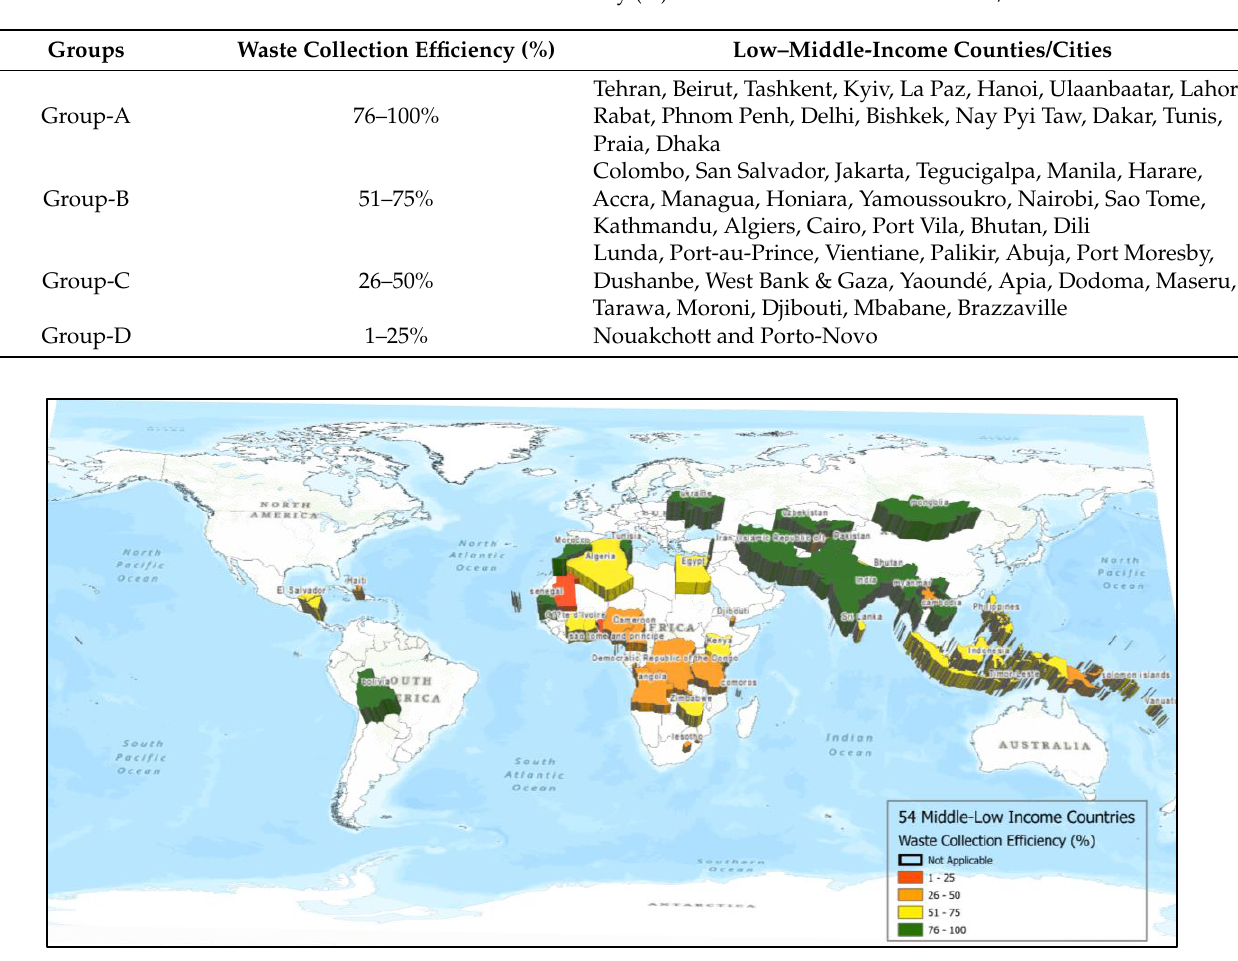
Table 1. Waste collection efficiency (%) in low–middle-income countries/cities.